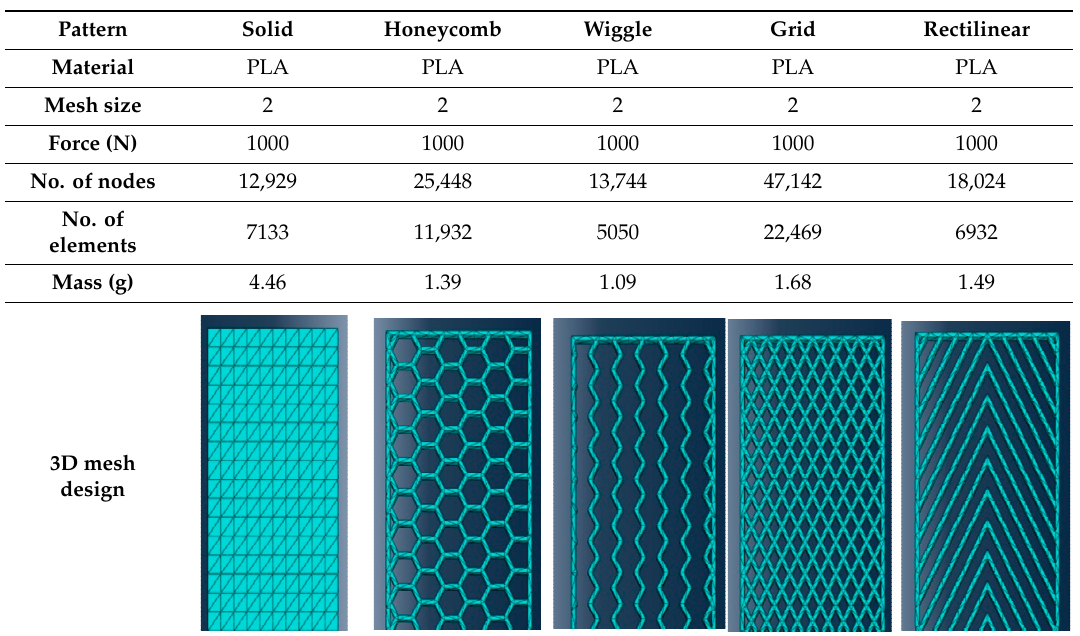
( b ) Figure 5. ( a ) Classified layers and ( b ) CAD model according to ISO/ASTM. On the other hand, FEA is a powerful technique to examine properties and product’s behavior under loads and tensions [73]. Finding the sample’s reaction was conducted by finite analysis due to its capability to examine various geometries. Hence, finding the behavior of each pattern is necessary to determine the defects in this case. As discussed in the literature, patterns showed different